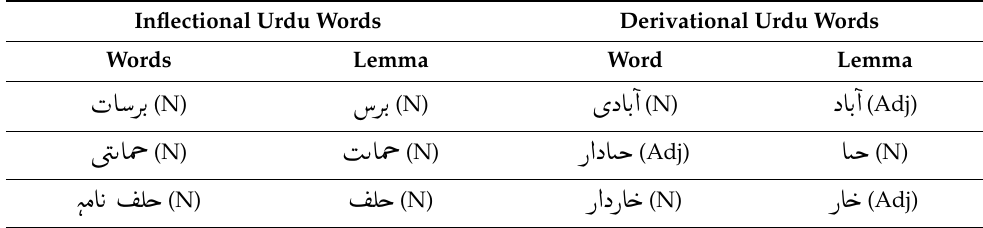
Table 8. A few examples of lemmatized inflectional and derivational words.